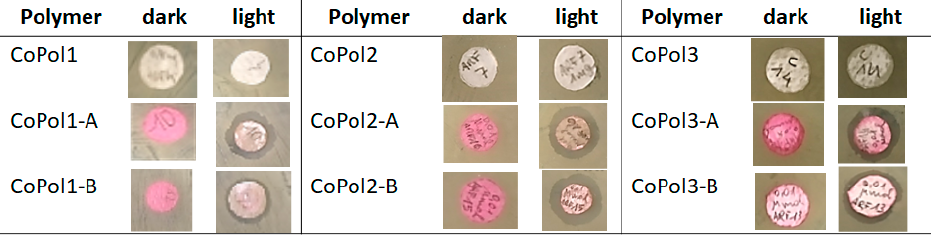
Figure 2. Representative images of antimicrobial assay on E. coli K12 ‐ MG1655. Bacterial cells were inoculated on LB agar and paper disks were placed on solid medium. Disks were prepared with polymers ( CoPol1 , CoPol2 , CoPol3 ) or polymers with BODIPYs A and B, respectively. After 2 h incubation at 37 °C, petri dishes were dark incubated or irradiated under green light. After overnight incubation at 37 °C, the antimicrobial activity was visible as a clear inhibition growth halo. The experiments were performed three times with independent bacterial cultures.